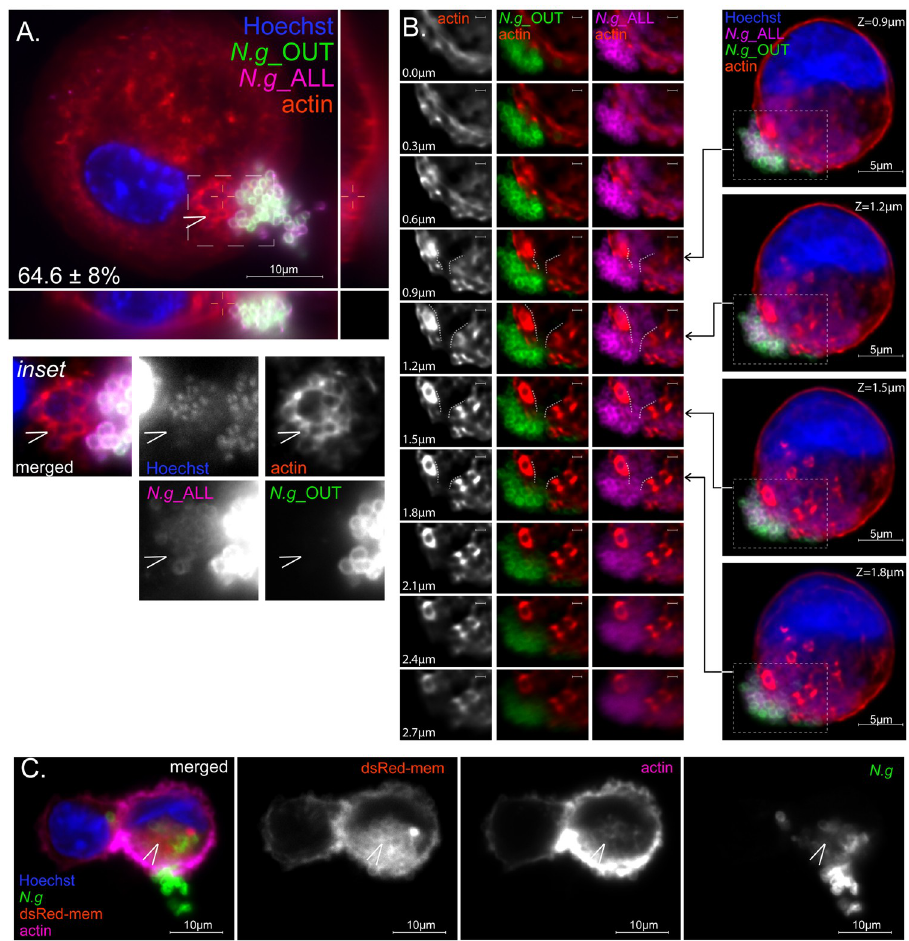
Fig 4. Actin microfilaments and membrane invaginations localize at plasma membrane sites colonized by hybrid gonococcal colonies. Micrographs show representative embedded gonococcal colonies on U937 MFs (MOI = 2) at 8hpi (A) and 10hpi (B) after inside/out differential staining. (A) Side panels show Z-axis reconstruction of the indicated cross-section. Inset shows polymerized actin accumulation (observed on 64.6 ± 8% of embedded colonies, n = 54) specifically on the intracellular region of the hybrid colony (arrowhead). (B) Embedded colonies are continuous. A series of single focal planes spanning 2.7 μ m shows that the transition point—from intracellular to extracellular region of an embedded colony is continuous and bracketed by cortical actin highlighted by the dashed lines. (C) Actin-rich plasma membrane invaginations surround the intracellular region of hybrid colonies (arrowhead). Single focal plane micrograph of a U937 MF stably expressing the plasma membrane-associated fluorescent reporter DsRed-mem and harboring a hybrid gonococcal colony. (A-C) Representative experiments from at least three biological replicates are